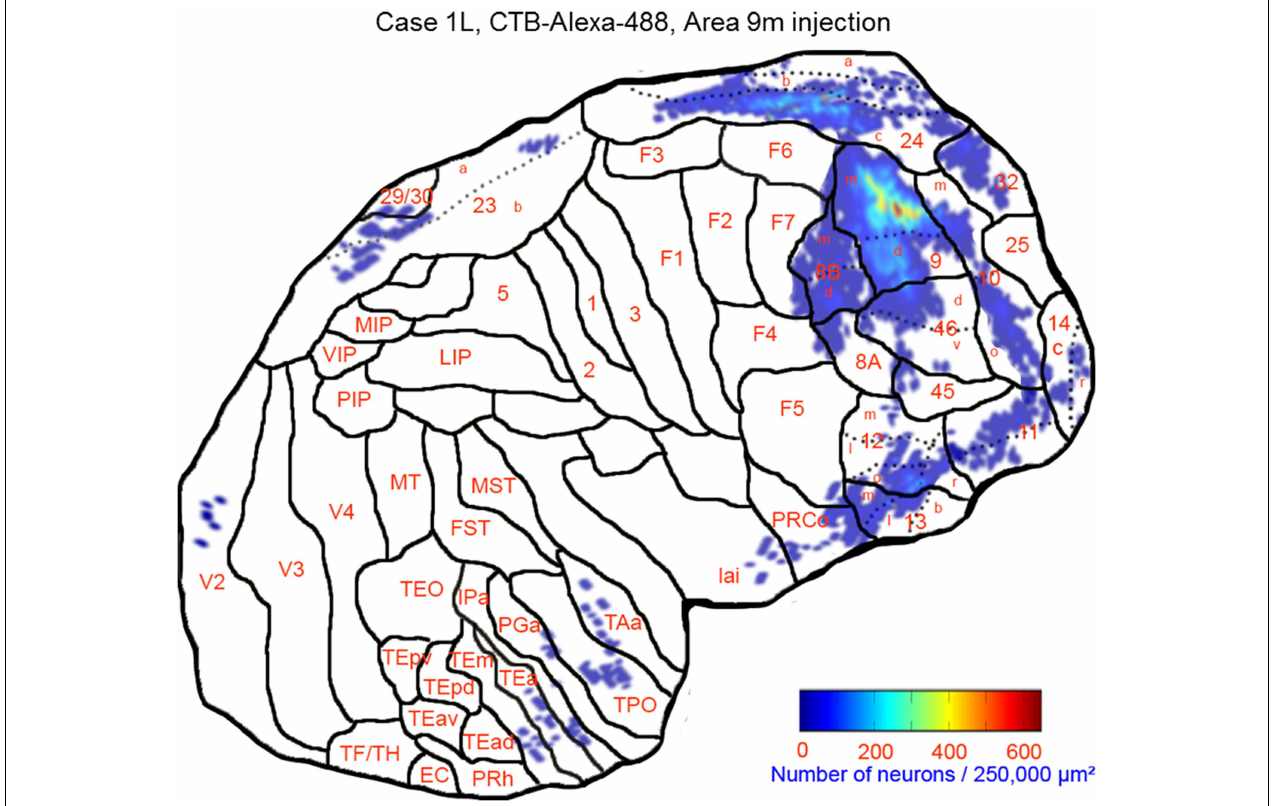
FIGURE 3 | Distribution of retrogradely labeled neurons on the flat map of the cerebral cortex in Case 1L. The density of labeled neurons was converted into a pseudo-color-code. The flat map was flipped horizontally to make the comparison between the cases easier.